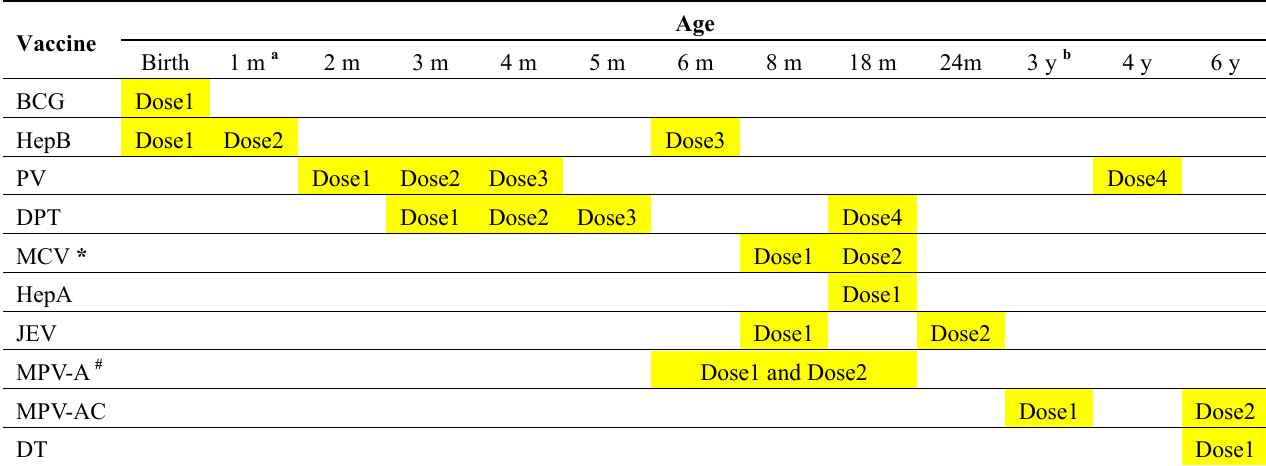
Table 1. Recommended children aged <7 years immunization schedule in